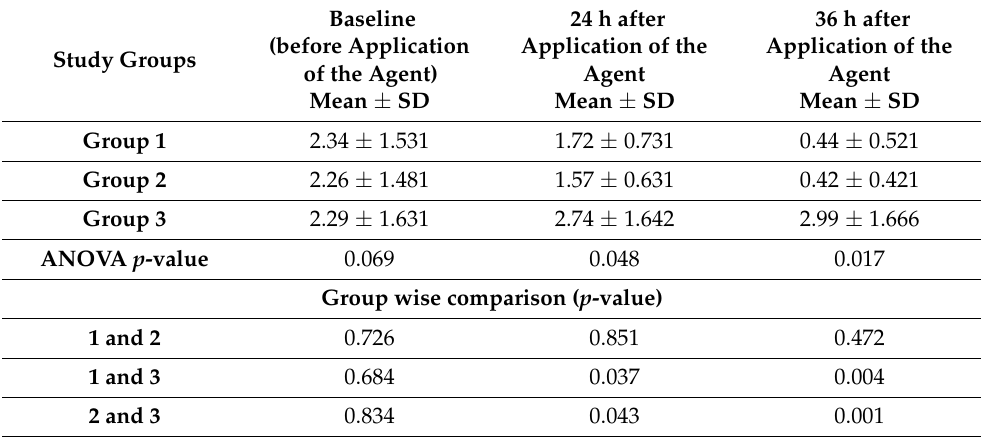
Table 2. Comparison of mean DIS score between the groups.